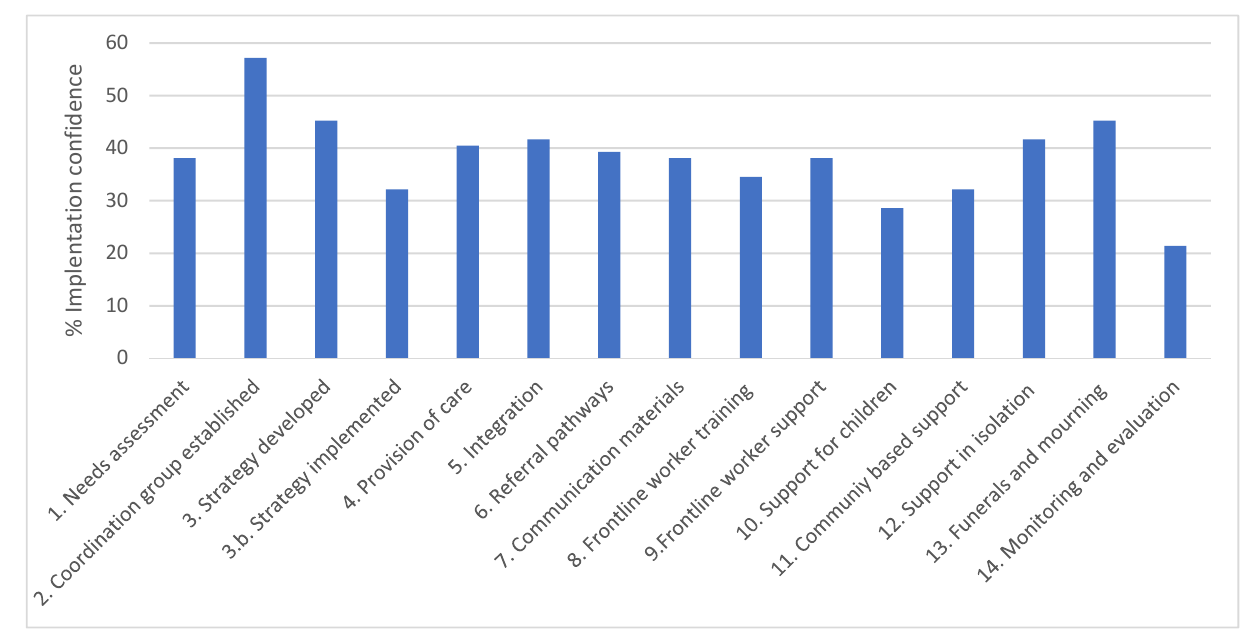
Figure 5. Implementation score by each IASC recommendation.